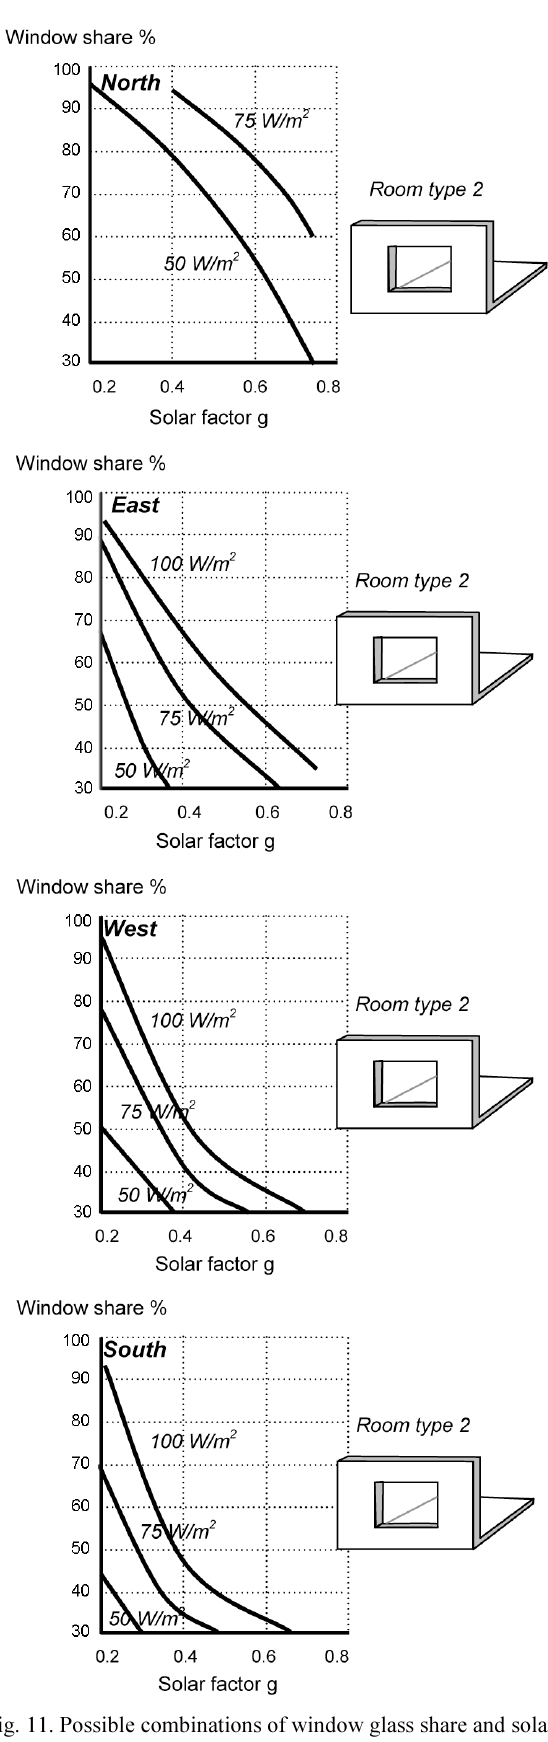
Fig. 11. Possible combinations of window glass share and solar factor for room type 2 for a maximum cooling power demand of 2 50, 75, or 100 W/m